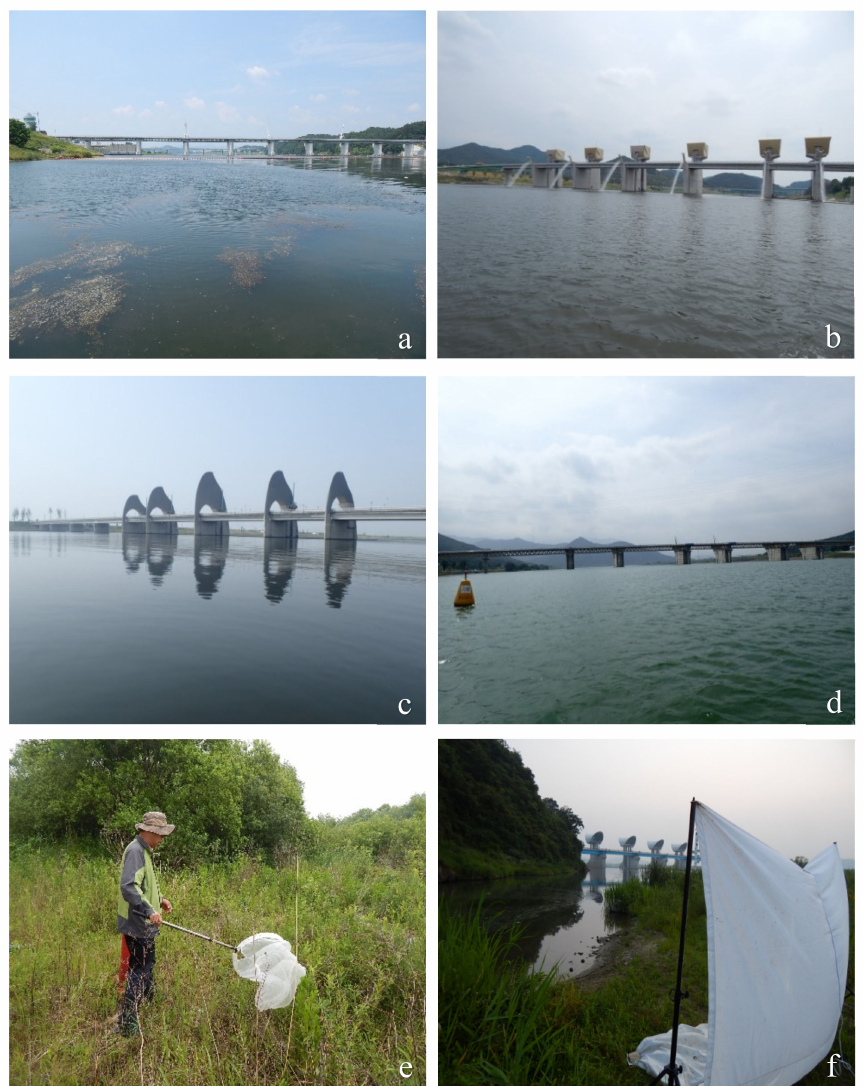
Figure 2. Chironomid sampling sites and collection methods. ( a ) Han River at Ipo weir; ( b ) Geum River at Sejong weir; ( c ) Yeongsan River at Seungchon weir; ( d ) Nakdong River at Danlseong weir; ( e ) sweeping along Han River at Ipo weir; ( f ) light-tarping along Yeongsan River at Seungchon weir. The sequences were aligned using the CLC Main Workbench (version 7.8.1; CLC